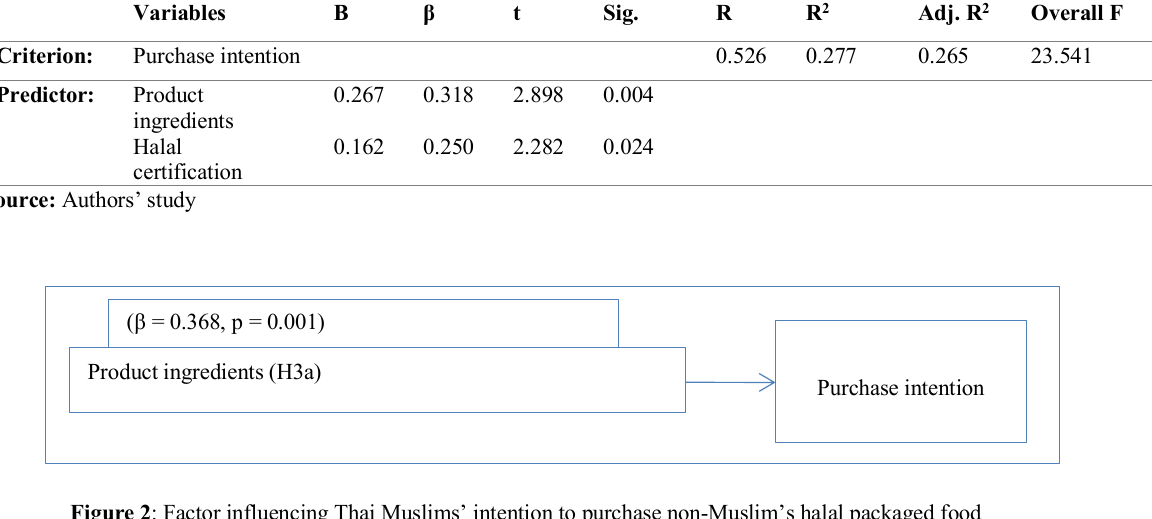
Figure 2 : Factor influencing Thai Muslims’ intention to purchase non-Muslim’s halal packaged food